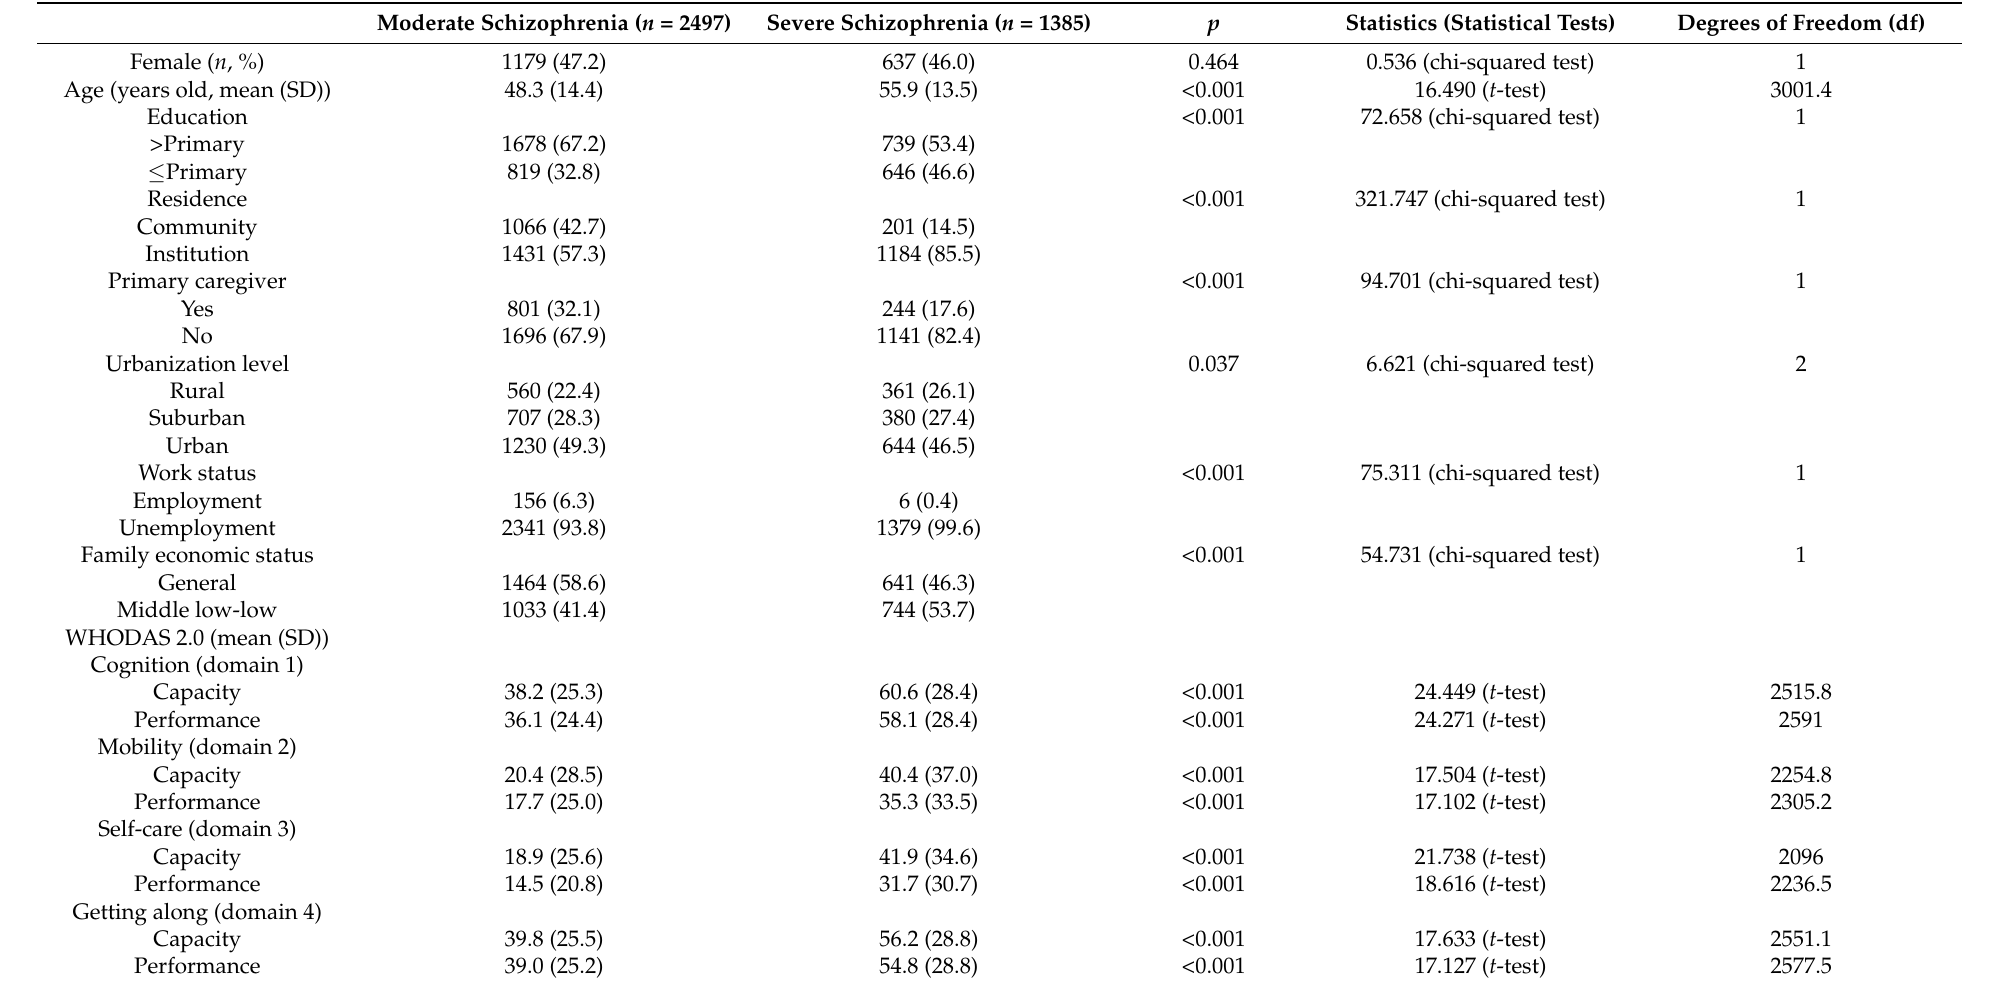
Table 2. Demographics of the study population and WHODAS 2.0 evaluation